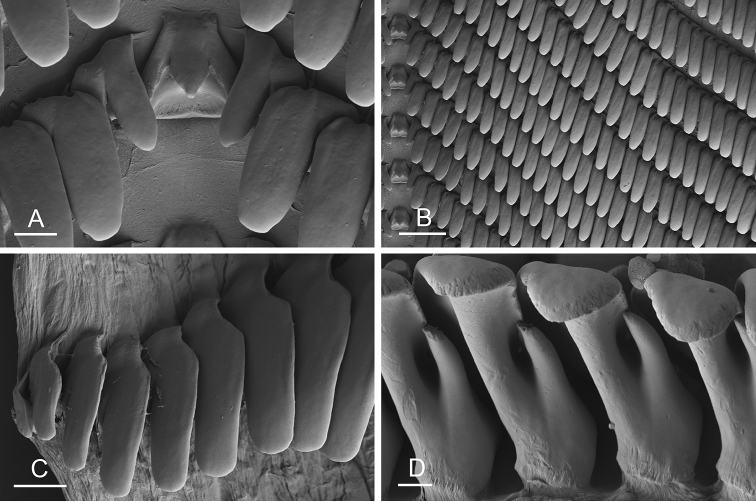
Radula, Peronia
verruculata (unit #3), Peninsular Malaysia A–C [976] (USMMC 00051) D [975] (USMMC 00064) A rachidian and innermost lateral teeth B rachidian and lateral teeth C outermost lateral teeth D lateral teeth, frontal view. Scale bars: 20 μm (A, C), 100 μm (B), 10 μm (D).